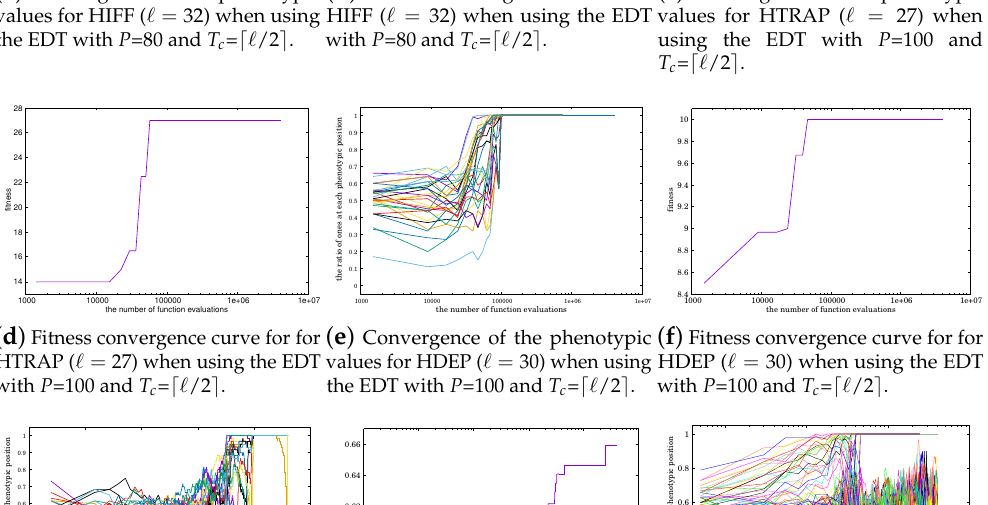
( b ) Fitness convergence curve for HIFF ( (cid:96) = 32) when using the EDT with P =80 and T c = (cid:100) (cid:96) /2 (cid:101) .